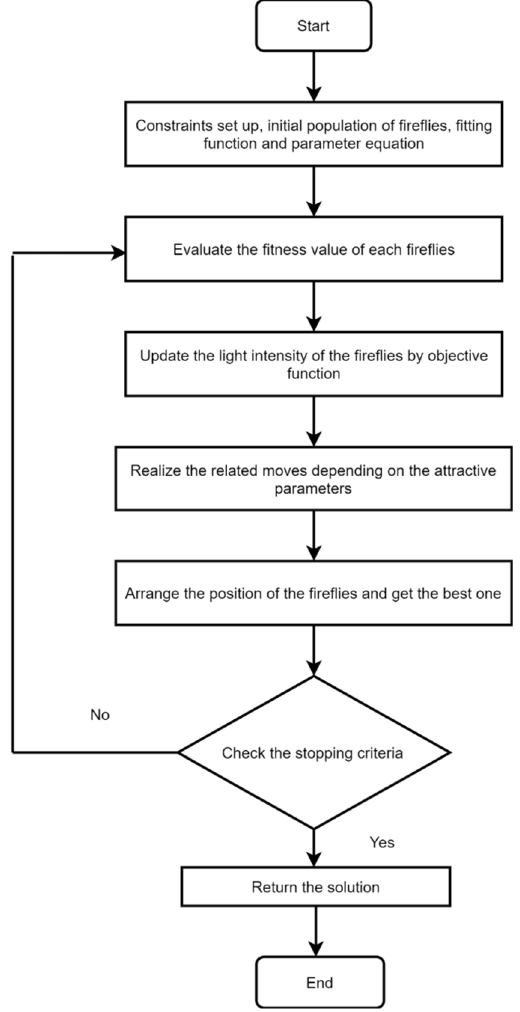
Figure 7. Flowchart of the firefly algorithm